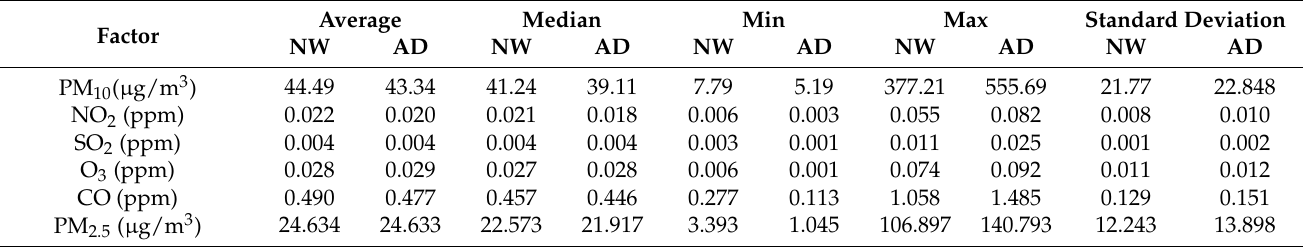
Table 4. Statistical description of daily air pollutant factor,